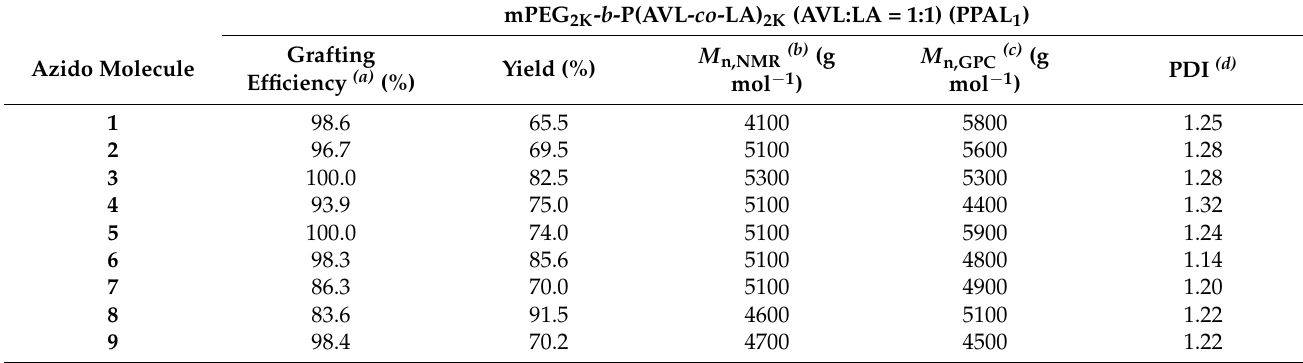
Table 2. Results of PPAL 1 copolymers click with azido molecules 1–9 via CuAAC